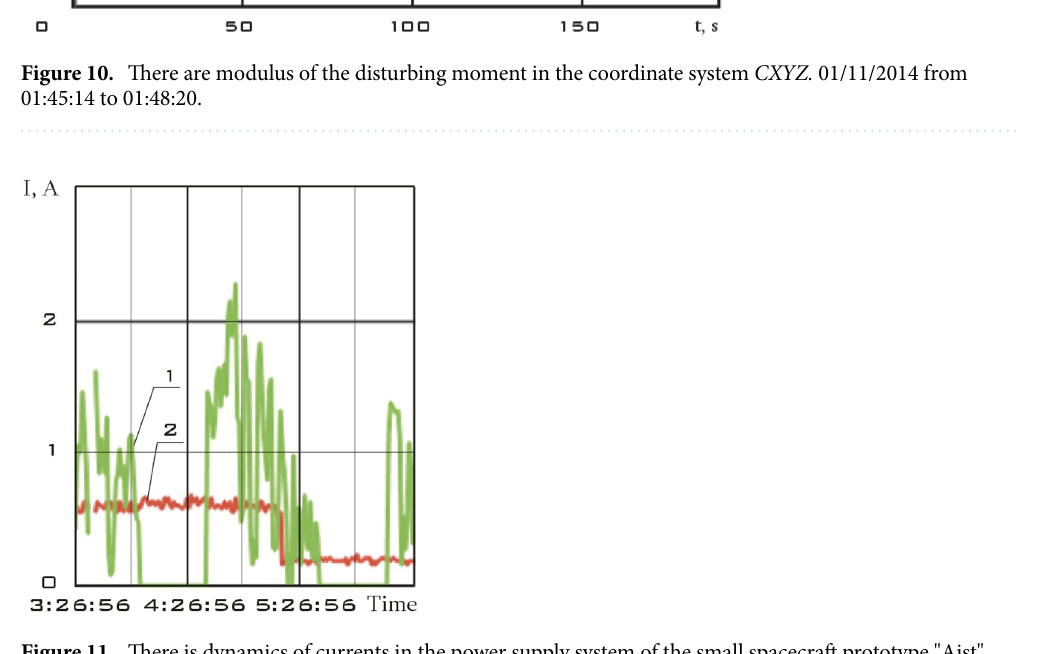
Figure 11. There is dynamics of currents in the power supply system of the small spacecraft prototype "Aist" according to telemetry data from 01/14/2014: 1 is battery charging current; 2 is current of power consumption of scientific